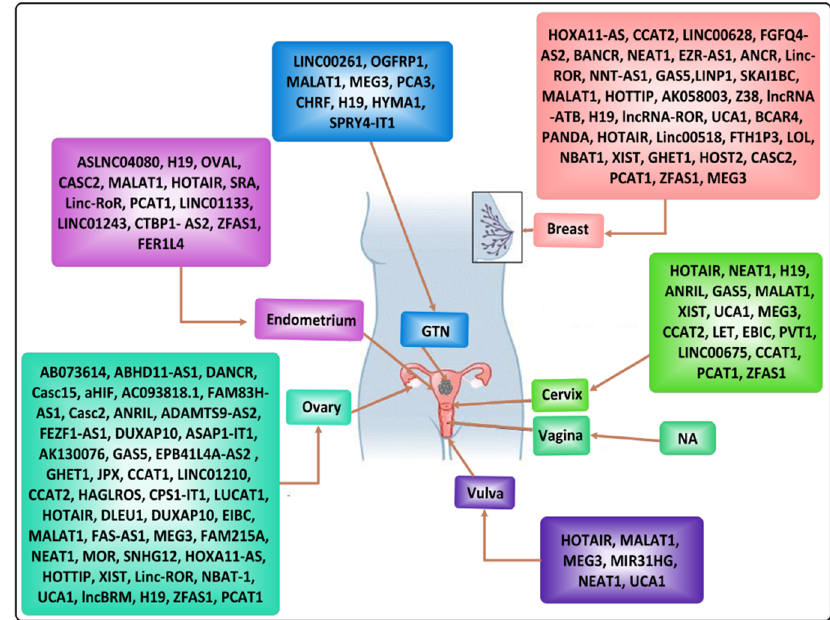
Figure 3. Most common lncRNAs associated with female-oriented cancers.